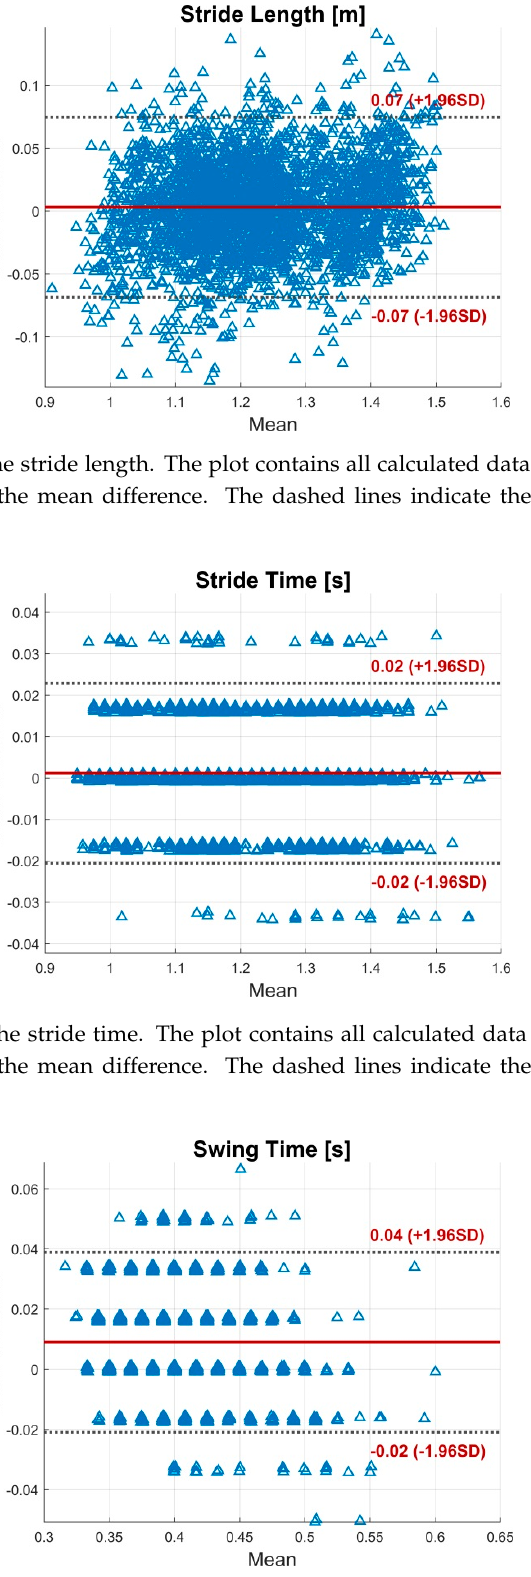
Figure A10. BA plot for the swing time. The plot contains all calculated data points of all subjects. The solid line indicates the mean difference. The dashed lines indicate the LoA (95% CI of the mean difference).